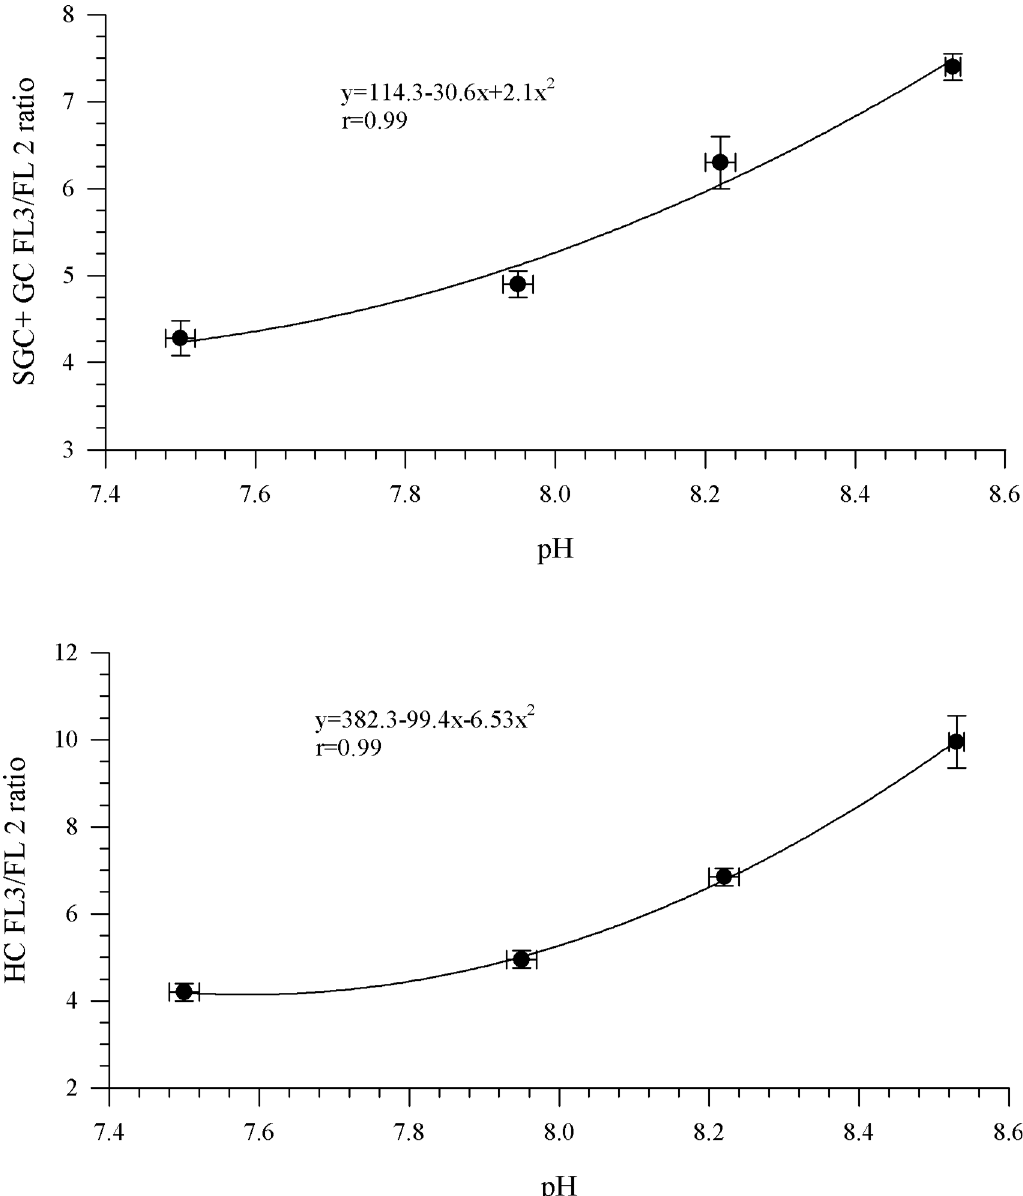
Fig 2. The calibration profile of Carboxy SNARF 1 for Chionoecetes bairdi , Tanner Crab. The slope of the line was used to calculate pH i of semi- granular+ granular cells and hyalinocyte cells.